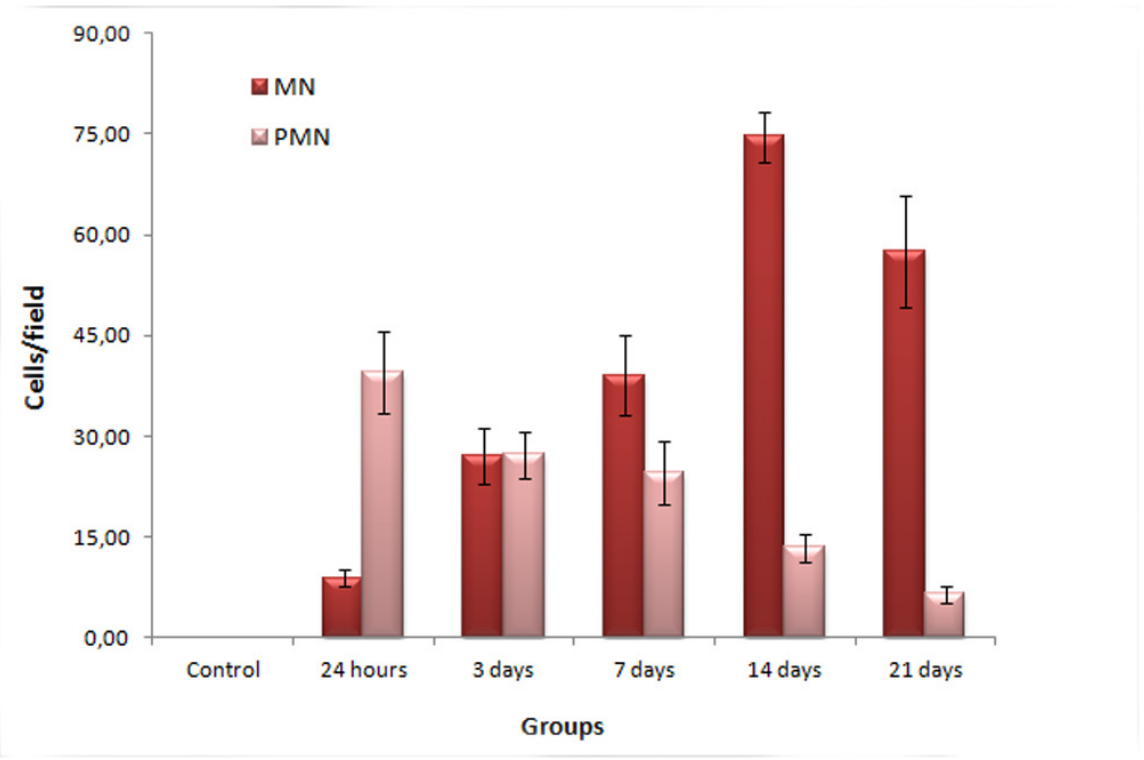
Figure 3. Determination of the number of mono- (MN) and polymorphonuclear (PMN) cells in the skin of mice after injection of Bothrops cotiara venom (100 µg/50 µL) or 0.9% NaCl solution (control group). Cell count was performed on histological HE-stained section of lesion areas of the skin where infiltrate was visible. Three random fields per section were analyzed, right below the lesion or the scab (magnitude: 400x). Results are represented as mean ± SEM.